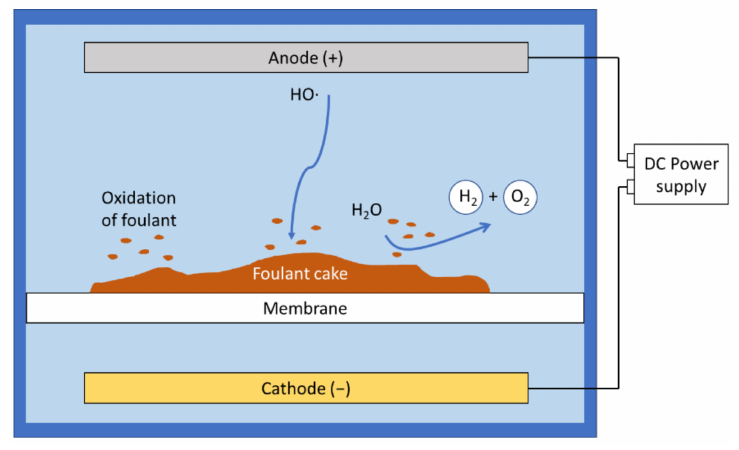
Figure 4. Electrolysis under a direct current field.